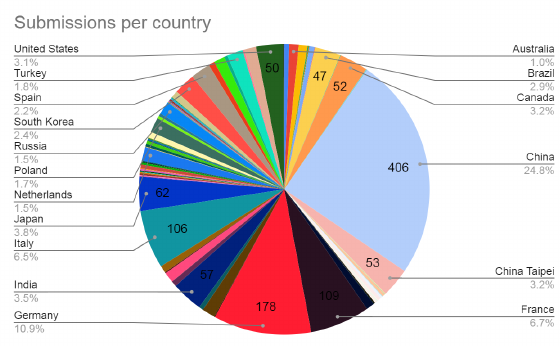
Figure 1. Submitted papers per country.